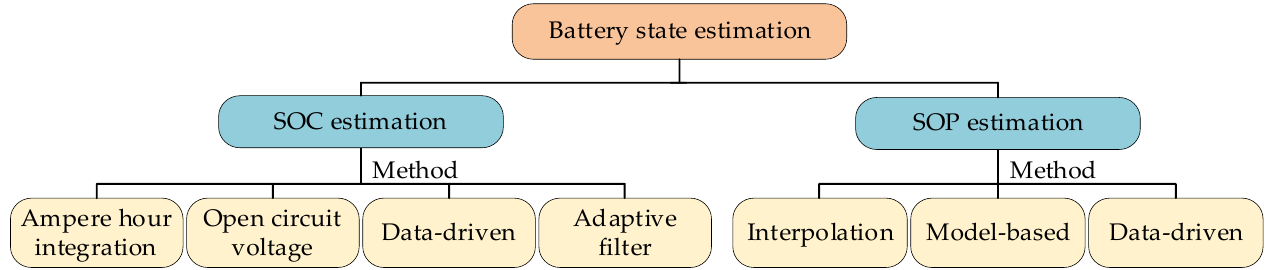
Figure 1. Battery state estimation methods classification.